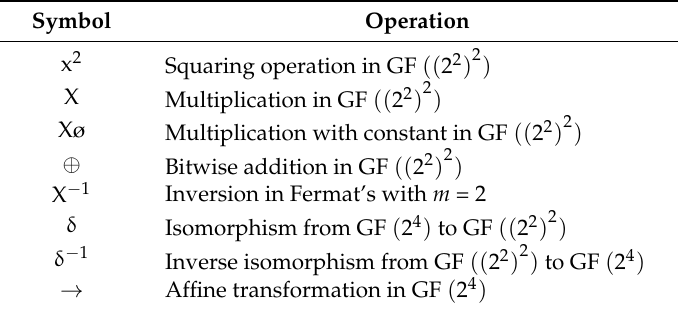
Table 2. Proposed S-box.